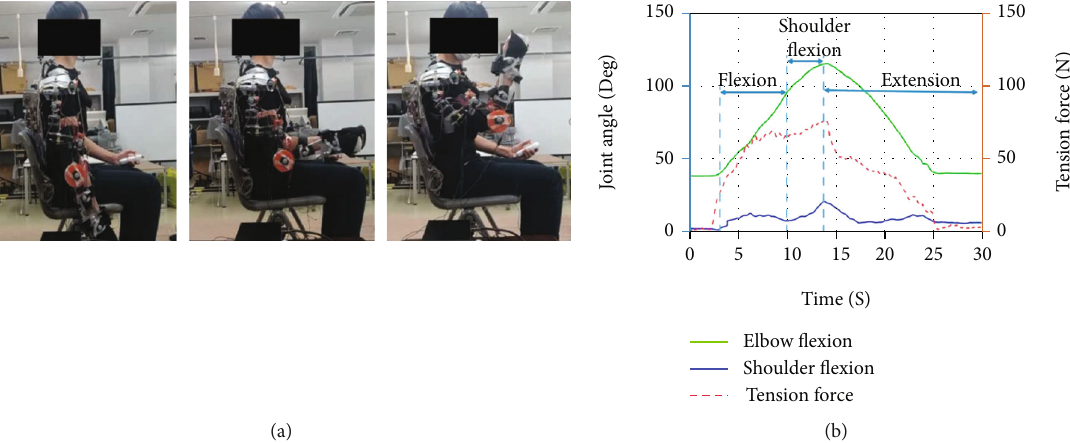
Figure 4: Subject wearing an assistive device performing maximum shoulder fl exion and extension. This movement acquires the subject to fl ex the elbow to the close to 90 deg, and then the upper arm will be brought to the upper limit of the arm ’ s reachable motion and then return to the initial position. Data (b) shows measured elbow fl exion angle, shoulder fl exion angle, and tension force versus